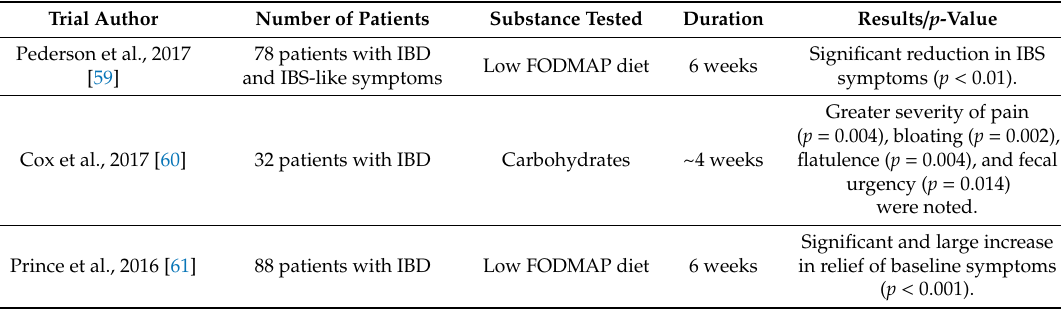
Table 5. Summary of trials examined for e ff ectiveness of Low FODMAP diet on